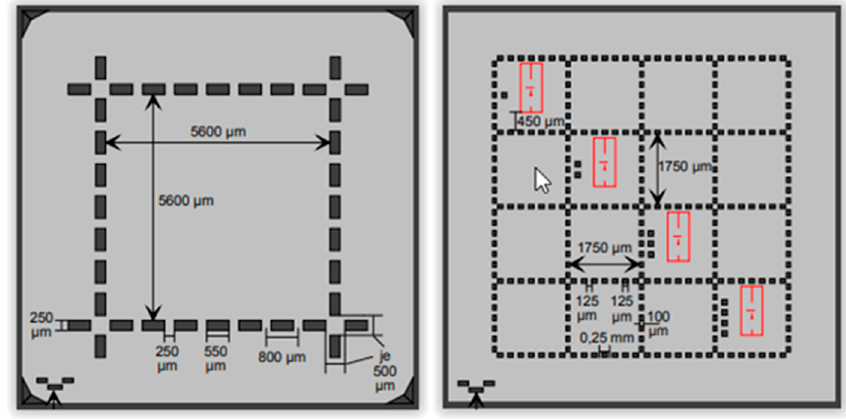
Figure 5. SiMETRICS Roughness Standard ARS (areal) Type ADT [26].